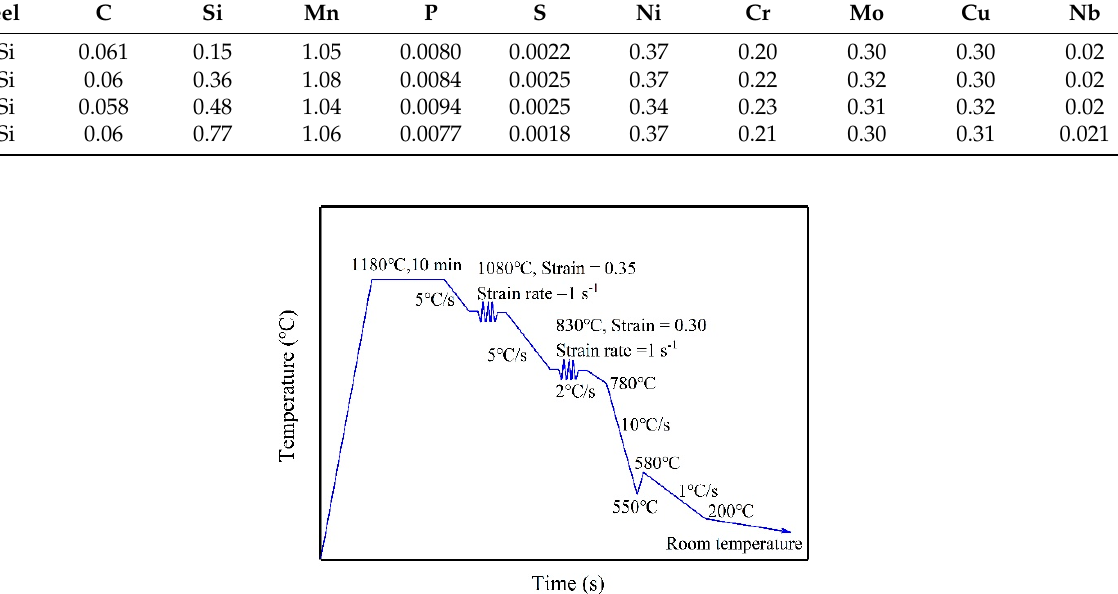
Table 1. Chemical compositions of four test steels (wt.%).